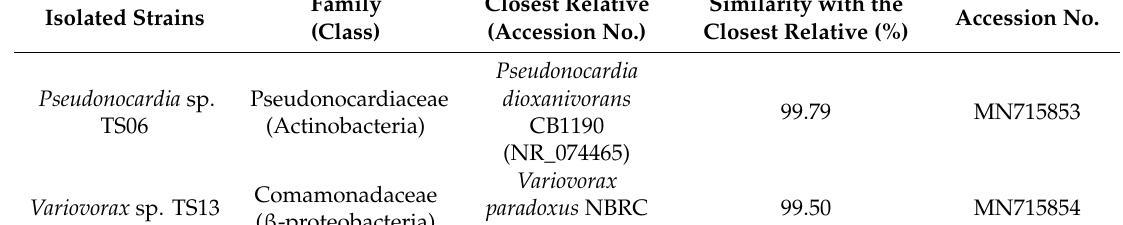
Pseudonocardia sp.